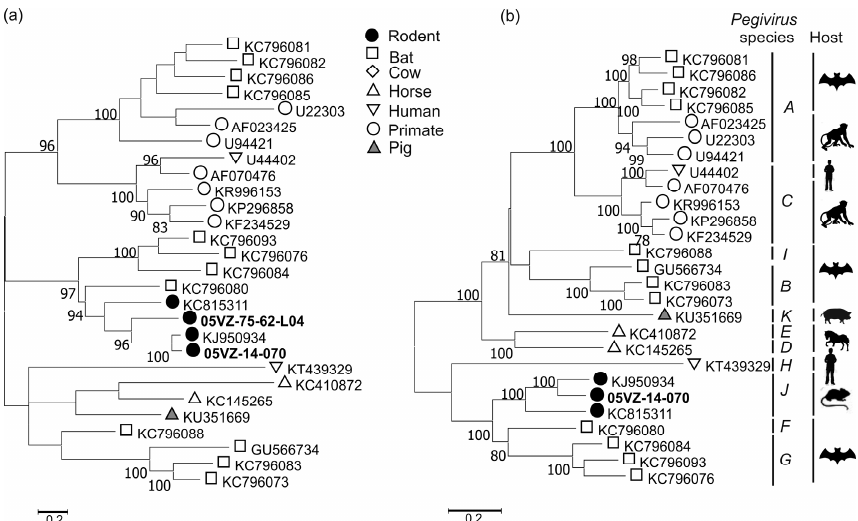
Figure 5. Maximum likelihood trees of ( a ) the screening fragment and ( b ) the region 888–1635 of pegiviruses using the best-fitting model of LG+G+I+F. Labels for sequences obtained in this study are highlighted in bold. Bootstrap support values of ≥ 70% are shown. The trees were drawn to scale; bar, estimated number of substitutions per site.